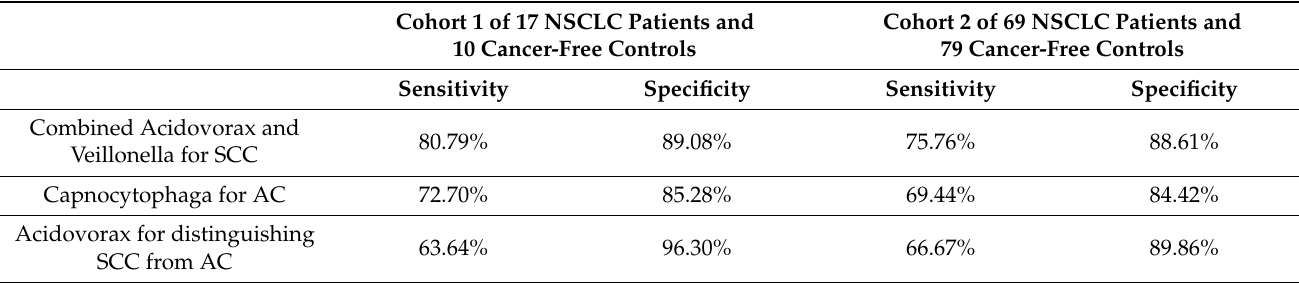
Table 5. The diagnostic values of the sputum bacterial biomarkers in contorts 1 and 2.